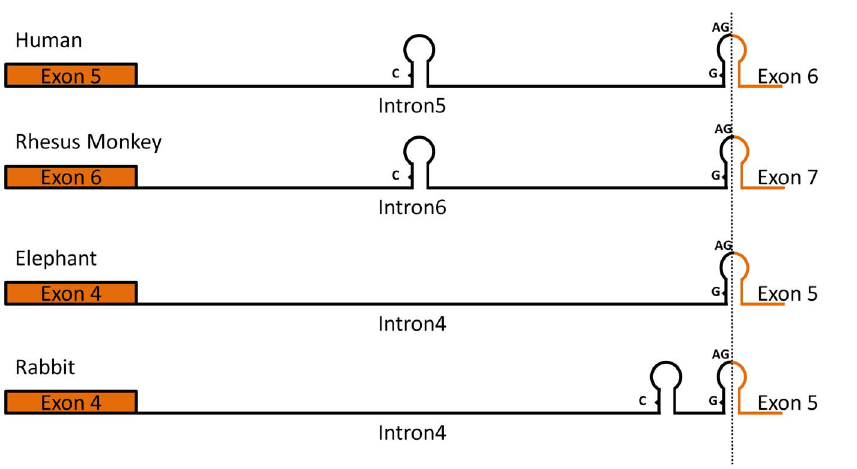
Figure 4. Potential iron-responsive elements (IREs) in the introns and intron-exon boundaries of UROS genes. IREs depicted as stem- loop structures are shown in the corresponding intron regions. UROS exon and intron IDs from four species are indicated. The conserved splicing acceptor site AG and the unpaired nucleotide of the IRE structure are also shown.